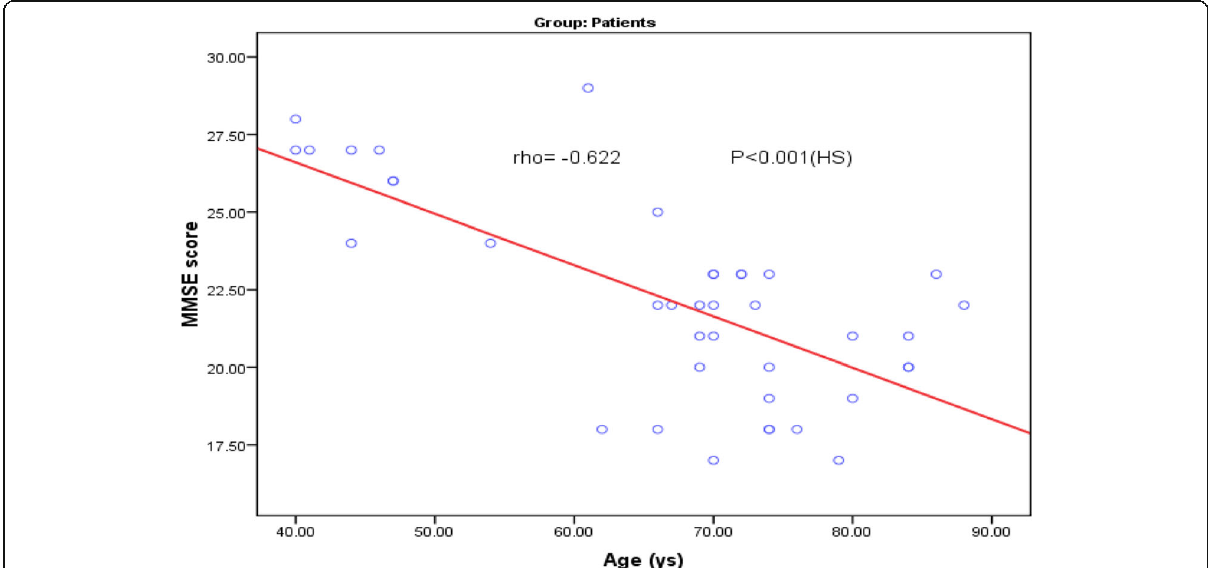
Fig. 2 Scatter graph showing a highly significant negative correlation between age and MMSE